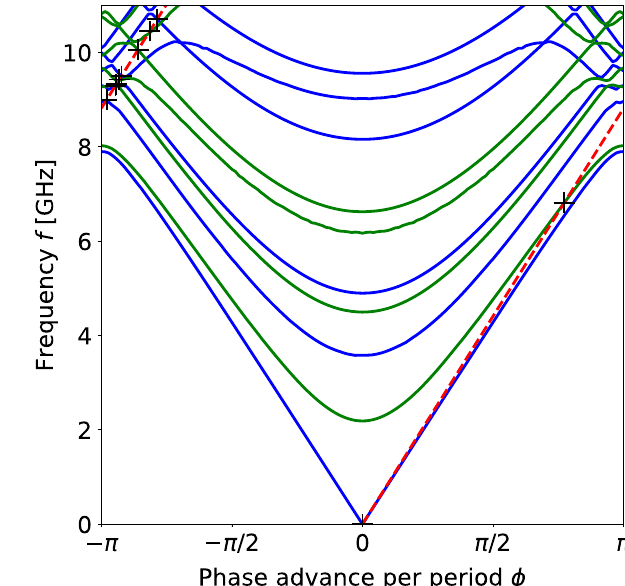
FIG. 10. Dispersion diagram for the FCC-hh beam screen with the slit width of 7.5 mm. The green lines correspond to longitudinal modes, and the blue lines correspond to transverse modes ( X direction). The synchronous points are marked with black crosses.